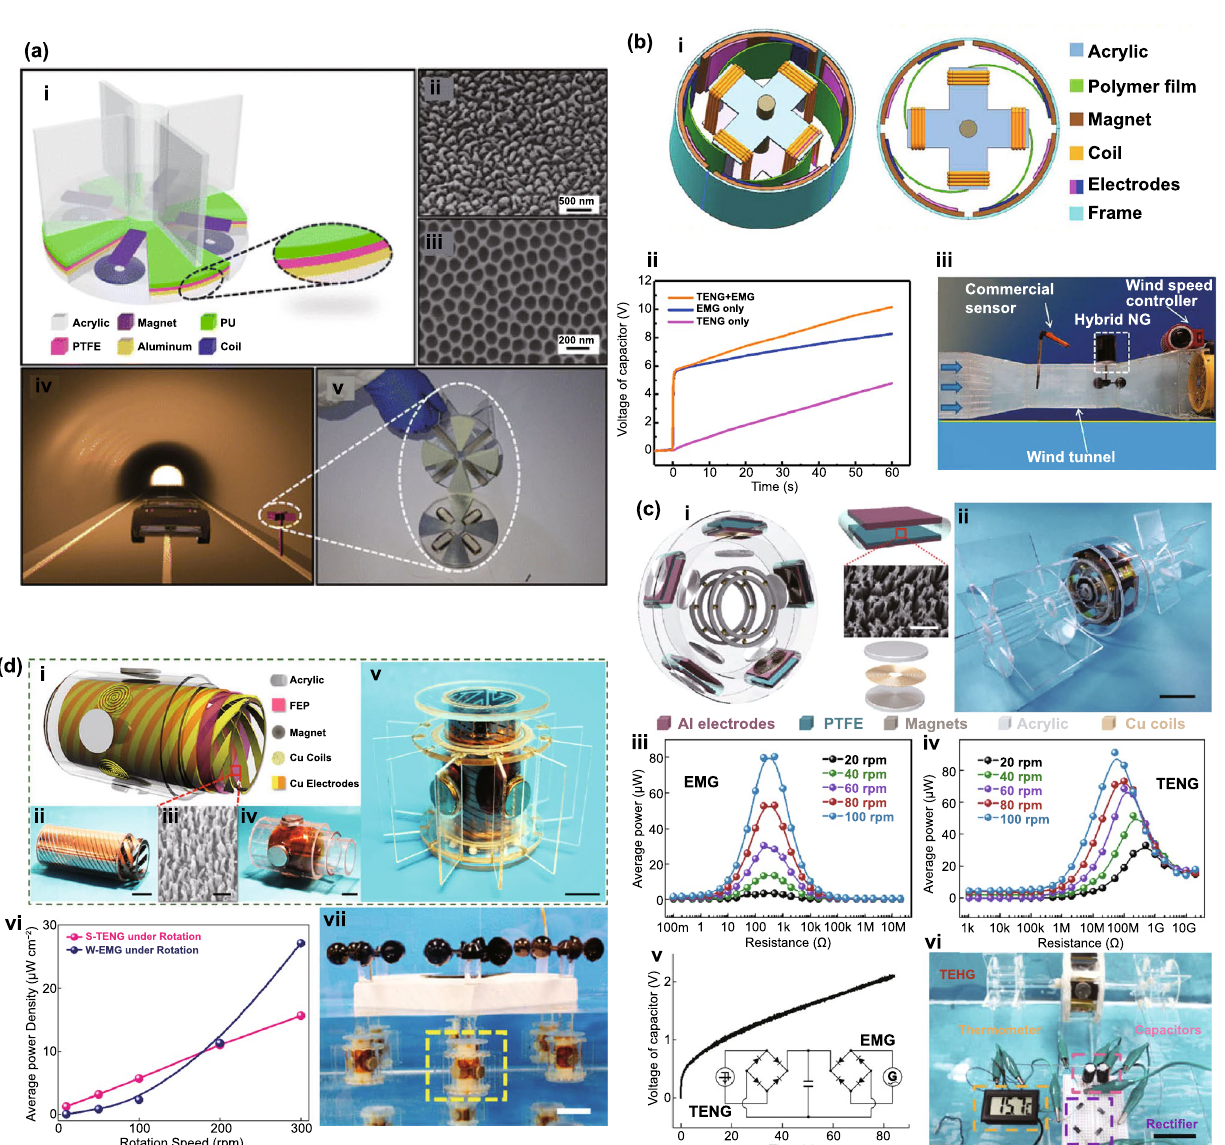
Fig. 12 a Structural design of the rotating-disk-based hybrid generator for self-powered wireless traffic volume sensing developed by Zhang et al. (i) Sketch of the generator. SEM image of the (ii) PTFE surface with nanostructures and (iii) aluminum surface with nanopores. (iv) Sche- matic diagram of the generator working in a tunnel. (v) Photograph of the self-powered sensing system. Reproduced with permission from Ref. [68]. Copyright permissions from 2016, American Chemical Society. b (i) Schematic illustration of the ultra-low-friction wind energy hybrid nanogenerator developed by Wang et al. (ii) Charging curve of a 100 μF capacitor by the TENG, EMG and hybrid generator. (iii) Demonstration of the ultra-low-friction hybrid nanogenerator for energy scavenging and self-powered wind speed sensing in a wind tunnel. Reproduced with permission from Ref. [69]. Copyright permissions from 2018, American Chemical Society. c (i) Schematic illustration and (ii) photograph of the blue energy hybrid generator, consisting of five contact-separation-mode TENGs and five rotary free-standing-mode EMGs, designed by Shao et al. Output average power of the (iii) EMG and (iv) TENG as a function of the load resistance and rotation rate. (v) Measured voltages of a 33 μF capacitor charged by the hybrid generator. (vi) Photograph of the self-powered water temperature sensing system, including rectifiers, capaci- tors and an electronic thermometer. Reproduced with permission from Ref. [70]. Copyright 2018, American Chemical Society. d (i) Schematic illustration of the functional components of the hybrid nanogenerator for harvesting broad frequency band blue energy developed by Wen et al., mainly consisting of a spiral-interdigitated-electrode TENG and a wrap-around EMG. Photographs of (ii) an as-fabricated TENG and (iv) an as- fabricated EMG (scale bars are 2 cm). (iii) SEM image of the FEP polymer nanowires in the TENG (scale bar is 500 nm). (v) Digital photograph of an as-fabricated hybrid nanogenerator. (vi) Optimized average power densities of the TENG and EMG operated under rotation. (vii) Photo- graph of the proposed comprehensive energy harvesting panel floating on the ocean for simultaneously harvesting wind, solar and wave energies. Reproduced with permission from Ref. [71]. Copyright 2016, Creative Commons Attribution 4.0 International License. (Color figure